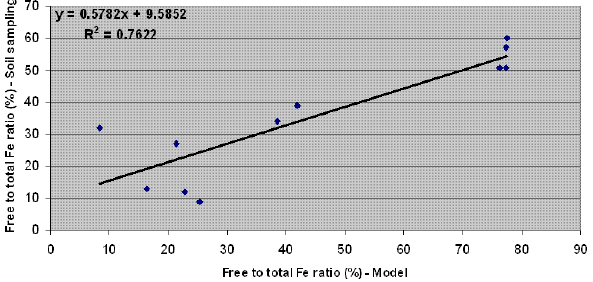
Fig. 2. Scatter diagram of observed f at 11 sites and values inter- polated from GMINER30 in these locations.